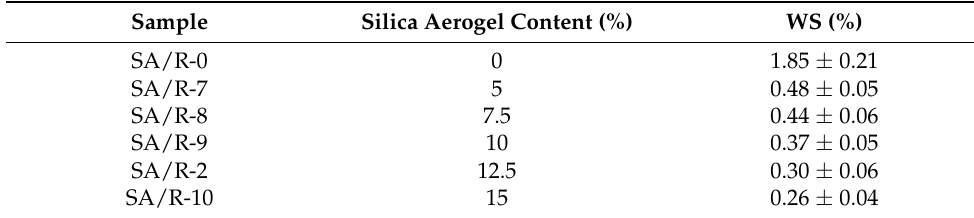
Figure 9. Effect of silica aerogel content on the flexural strength of the silica aerogel/resin compo- sites.